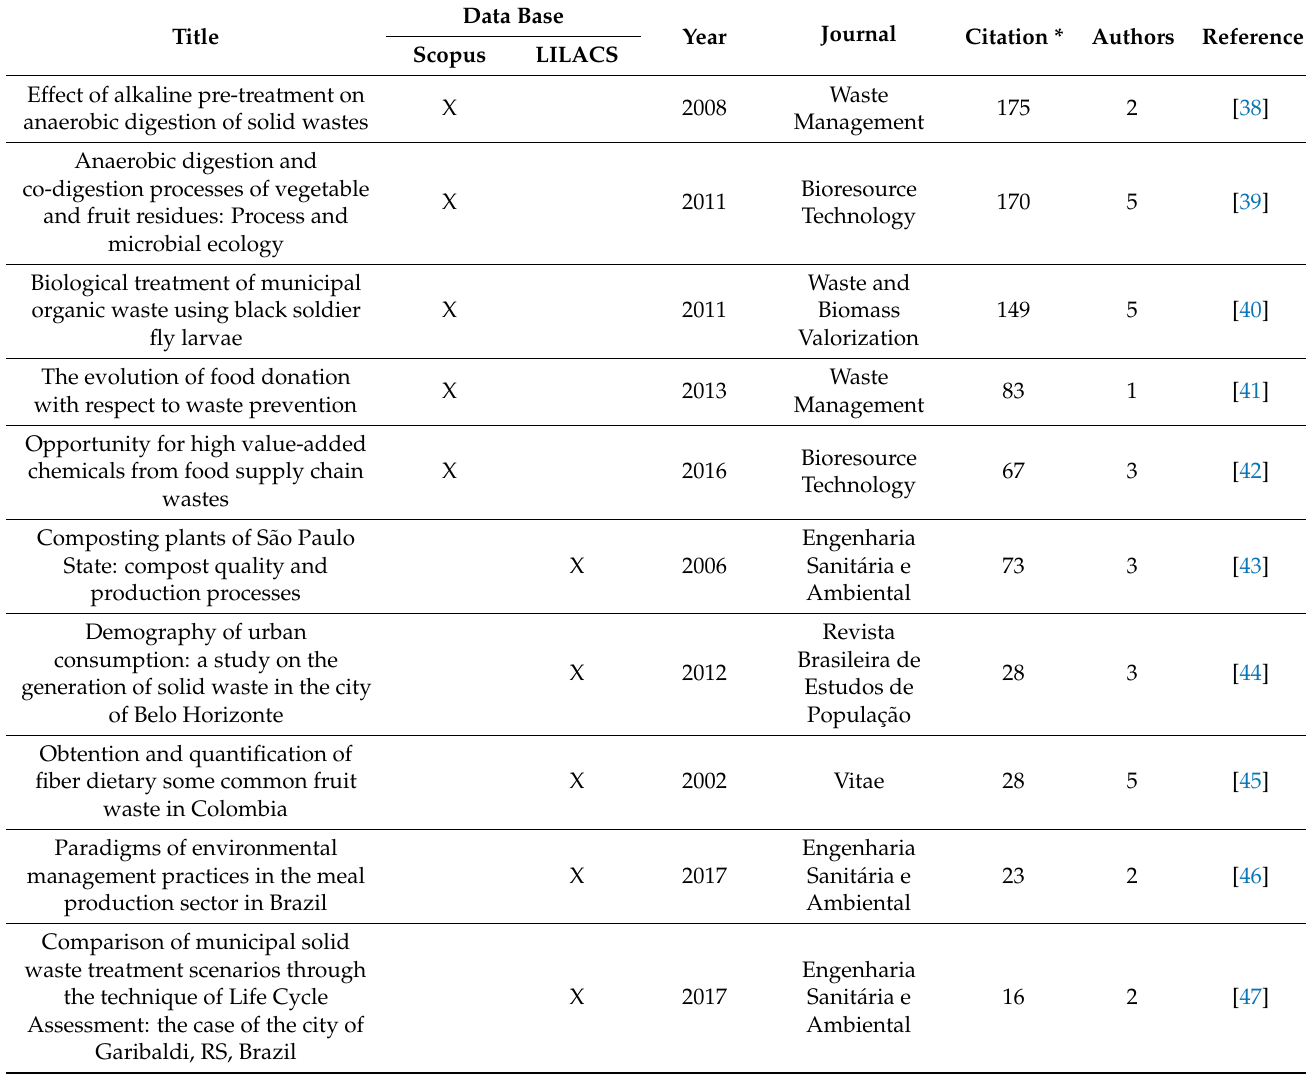
Table 2. Highly cited articles from Scopus and LILACS and metrics